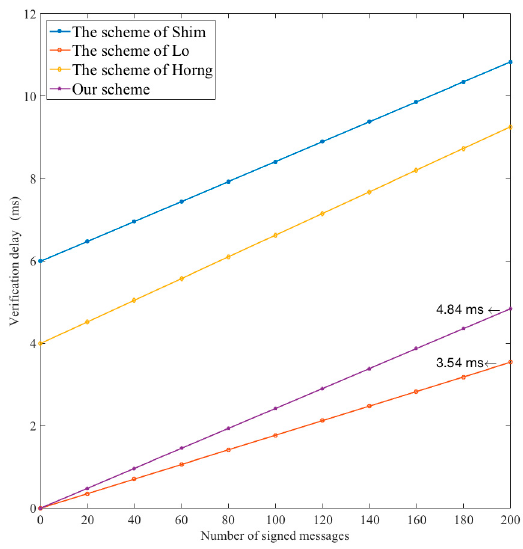
Figure 8. Comparison of execution time for the batch verification.